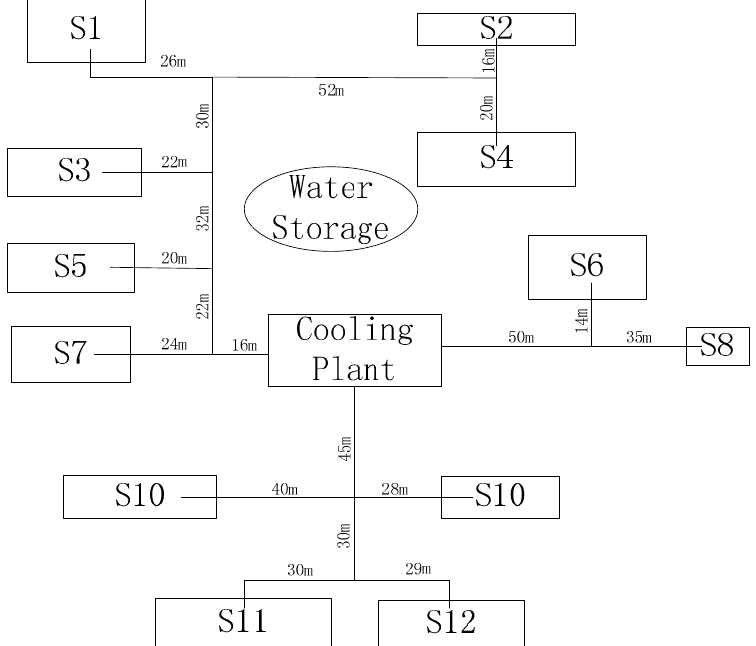
Figure 3. Locations of sub-buildings and water networks.